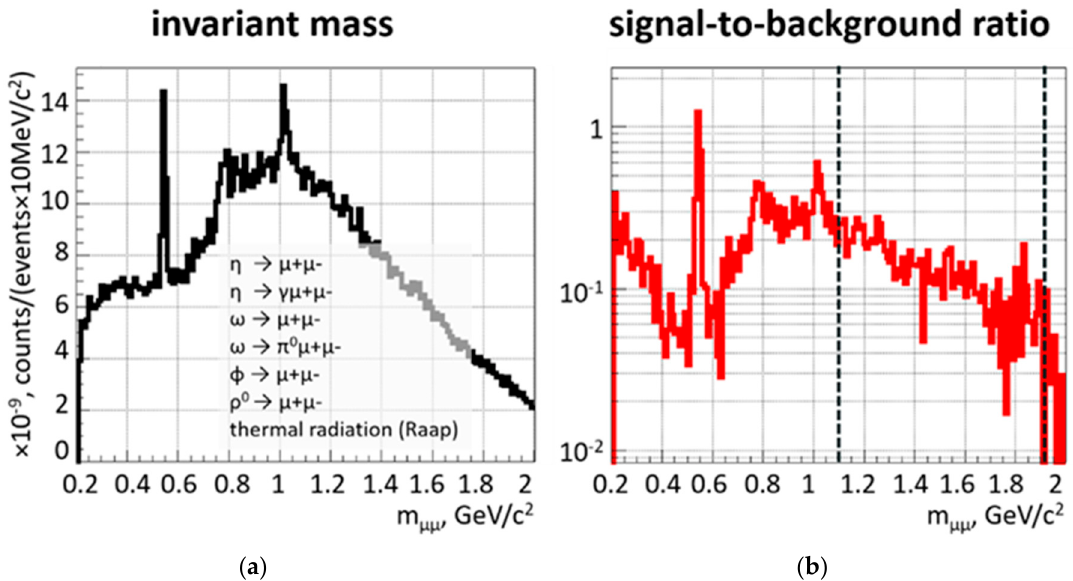
Figure 7. ( a ) Reconstructed invariant mass distributions including the decays of η , ω , ρ , and ϕ mesons, and from thermal radiation from the fireball in central Au + Au collisions at 8 A GeV/c. ( b ) Corresponding signal-to-background ratio.